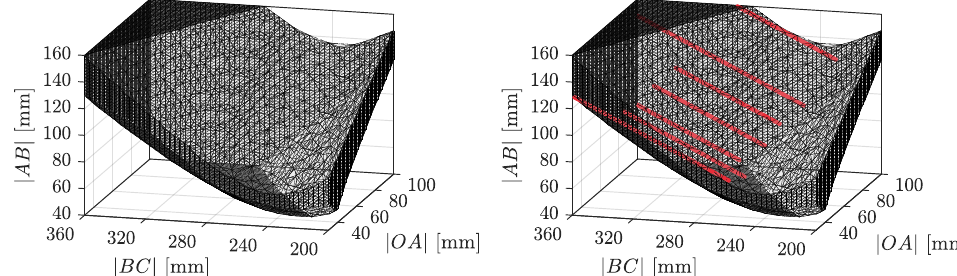
Figure 15. Region of interest delimited by (7) and (8) at the left and sampling locations on l = 7 parallel lines at the right in red.